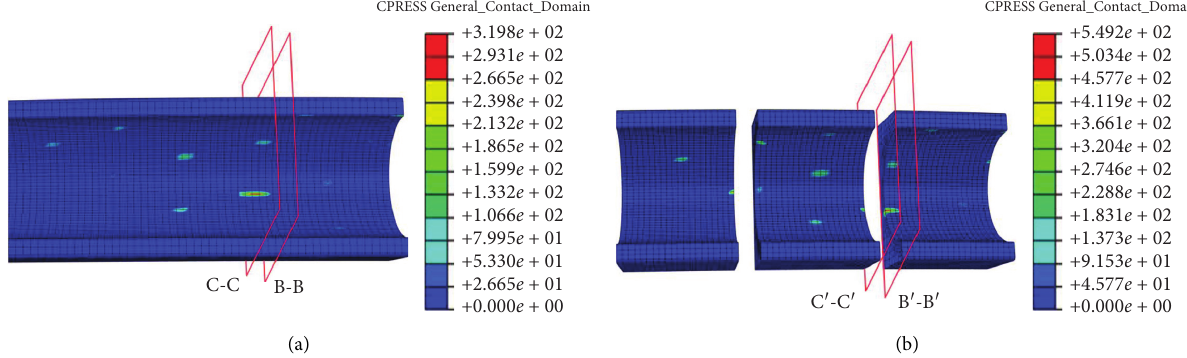
Figure 12: Contact stress nephogram of continuous and discontinuous rope grooves. (a) Contact stress distribution of the continuous rope groove contact model. (b) Contact stress distribution of the discontinuous rope groove contact model.